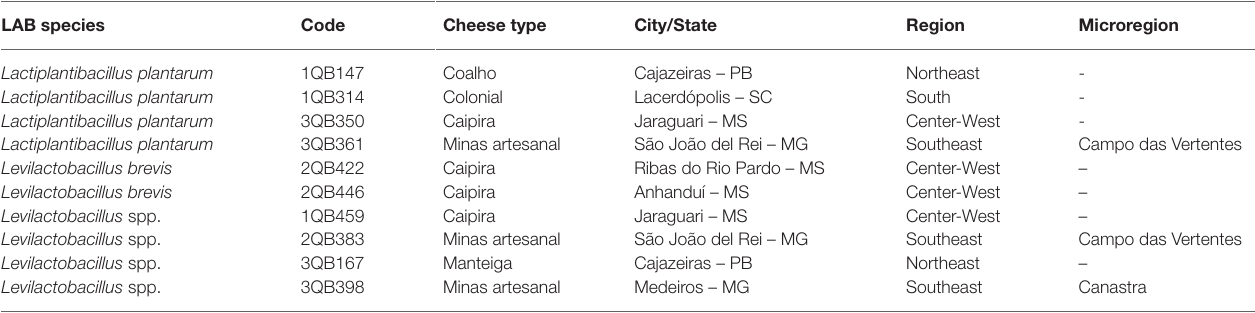
TABLE 1 | Identification and source of lactic acid bacteria (LAB)